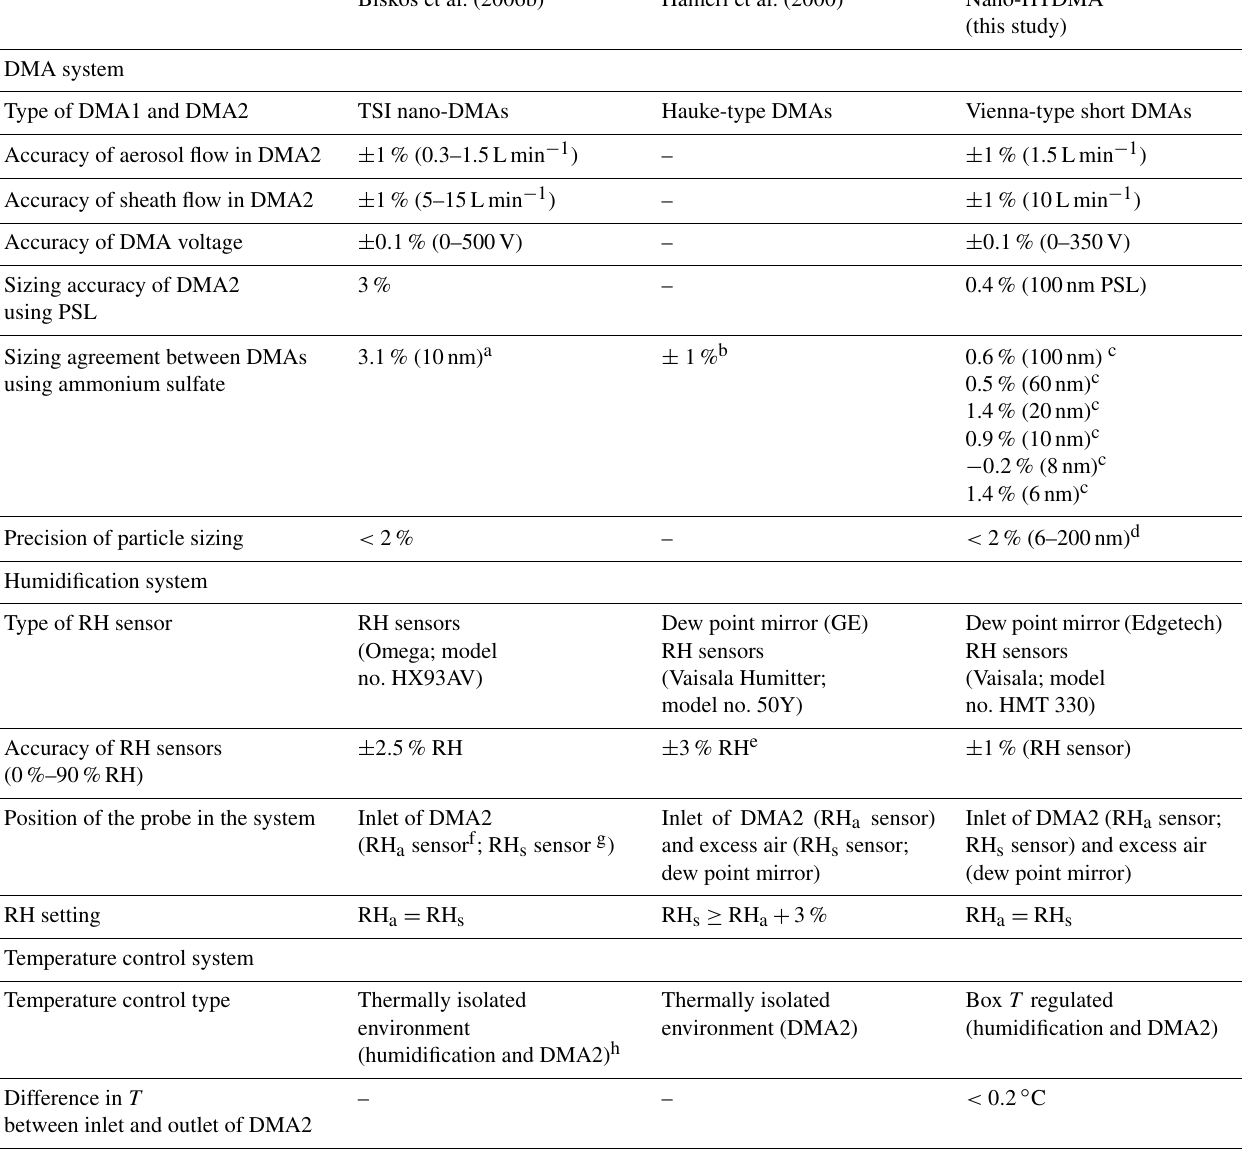
Table S2. d Value calculated according to the relative standard derivation. e From the Vaisala Humitter model no. 50Y manual. f RH a – the RH of aerosol flow. g RH s – the RH of sheath flow. h Bezantakos et al.